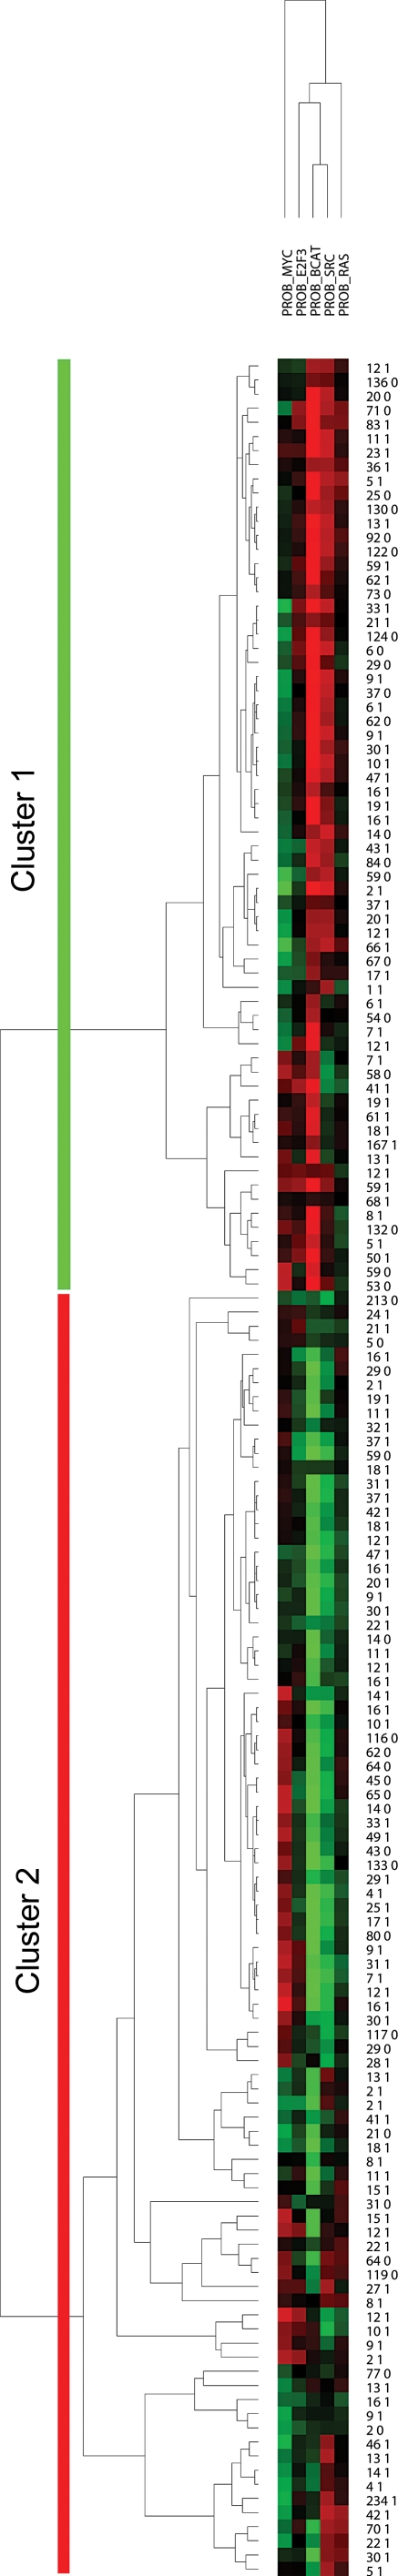
Heatmap Showing Predicted Probabilities of Pathway Activation for the Five Oncogenic PathwaysPathways are c-Myc, H-Ras, c-Src, E2F3, and β-catenin in our 157 ovarian tumor samples. Red indicates a high probability of activation and green indicates a low probability of activation. The probabilities of pathway activation were clustered according to the uncentered correlation measure. On the right of the figure the follow-up in months is depicted followed by the censoring status for each of the 157 samples.